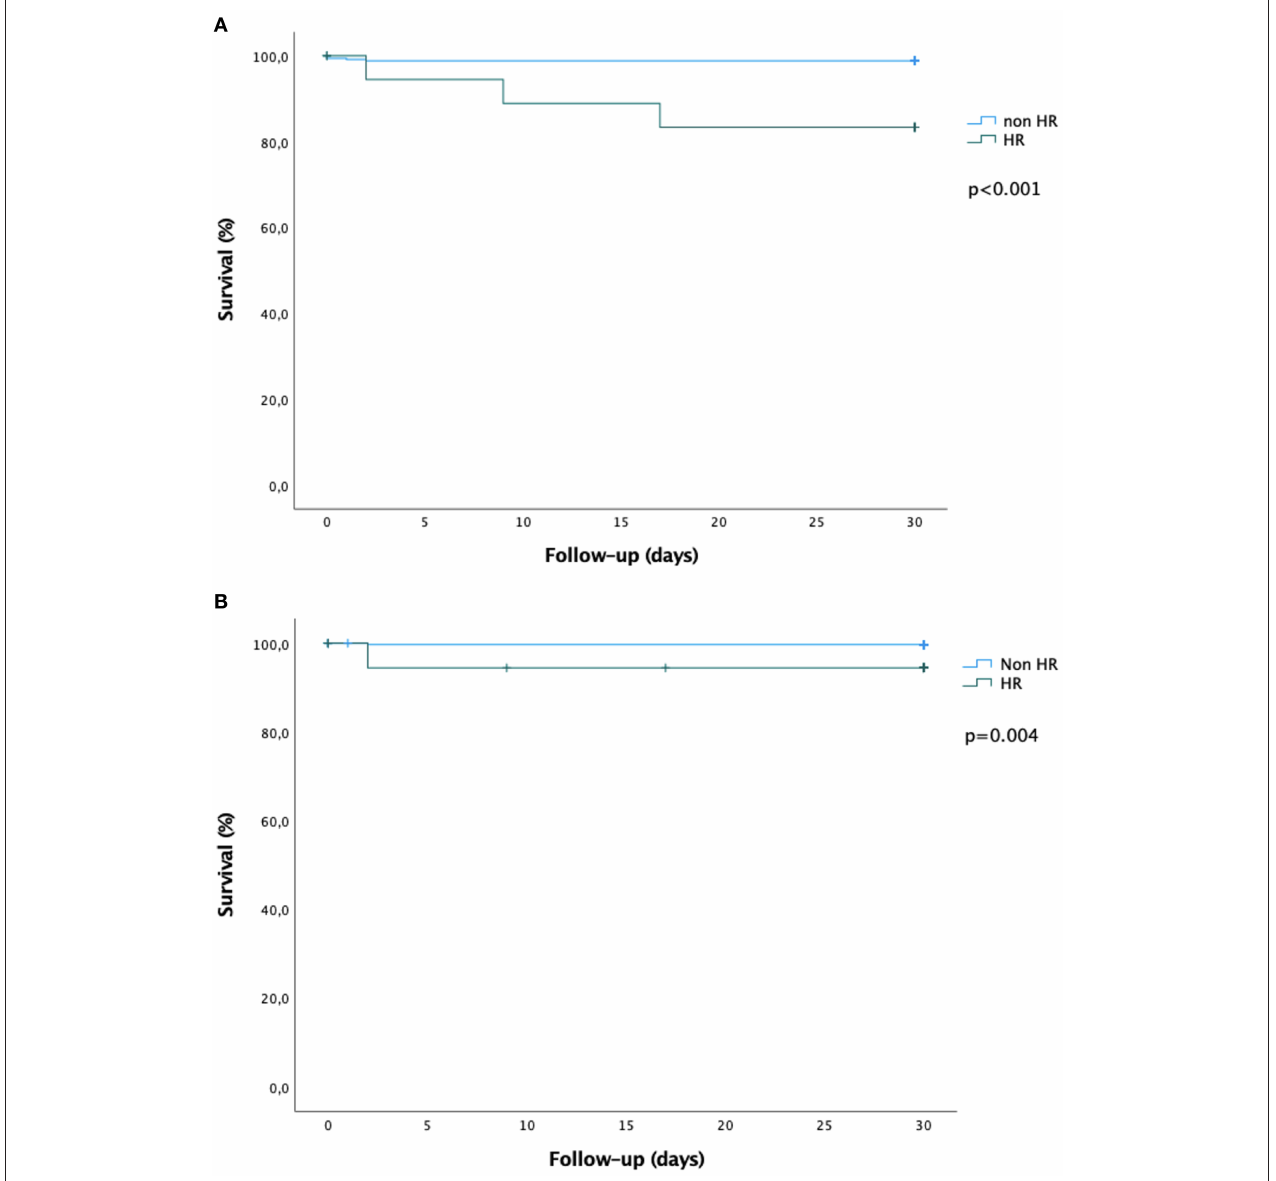
FIGURE 3 | Kaplan-Meier survival curves at 30 days. (A) All-cause mortality. (B) Mortality related to digestive ischemia. The green curves represent the high-risk group, the blue curves represent the non-high-risk group. Survival curves were compared using the log-rank